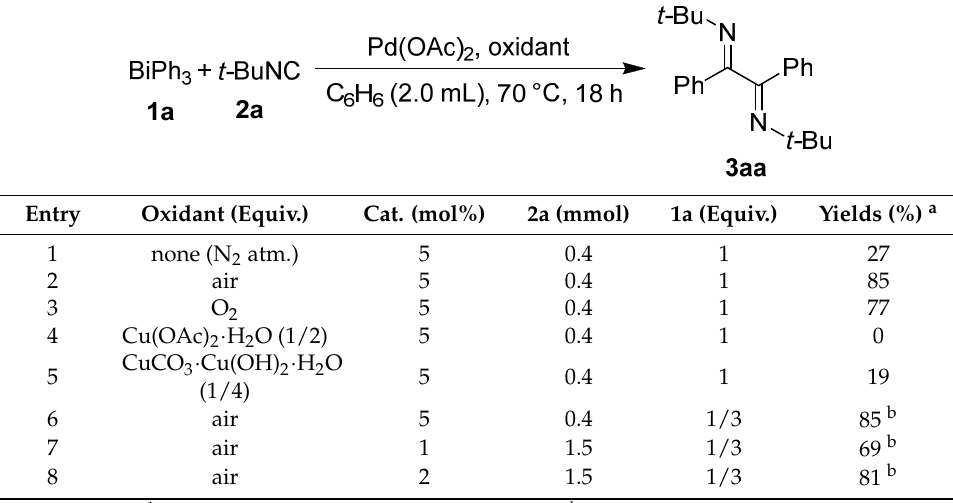
Table 4. Influence of oxidants on Pd-catalyzed diarylation of t -BuNC with BiPh 3 .